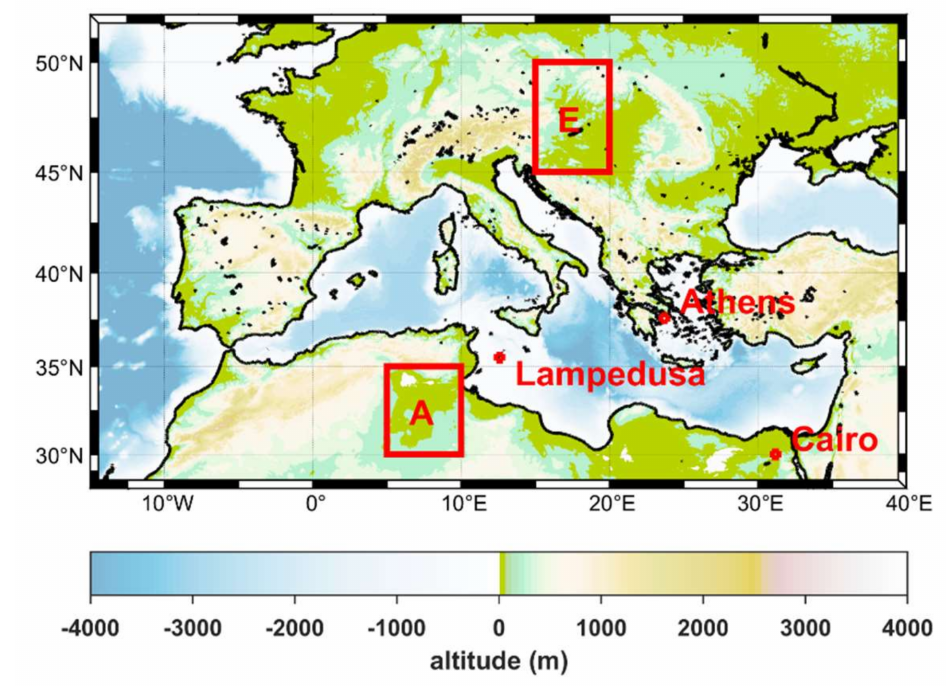
Figure 2. Map with the areas and the sites for which analyses were performed. A and E represent the two areas in northwest Africa and central-eastern Europe, respectively, for which the LIVAS profiles were